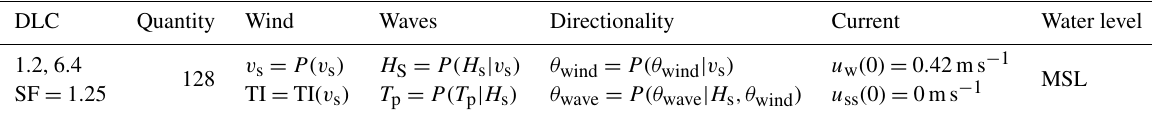
Table 2. Considered design load sets according to IEC-61400-3 (International Electrotechnical Commision, 2009) for the fatigue limit state (SF: partial safety factor, v s : mean wind speed, P : probability density function, TI: turbulence intensity, H s : significant wave height, T p : wave peak period, θ wind : wind direction, θ wave : wave direction, u w : near-surface current velocity, u ss : subsurface current velocity, MSL: mean sea level). Yaw error is normally distributed with − 8 ◦ mean value and 1 ◦ standard